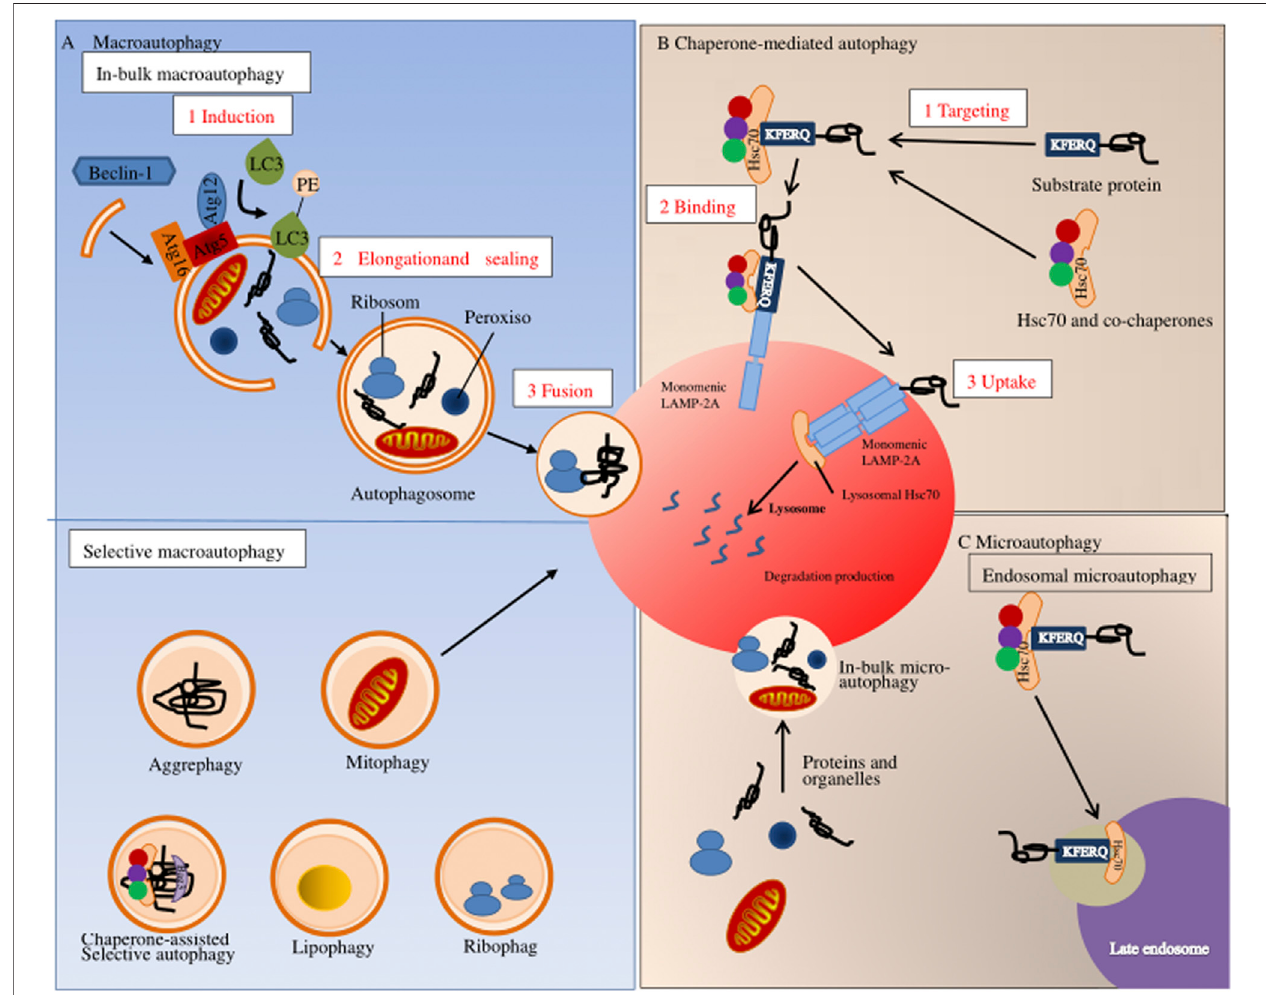
FIGURE 2 | Autophagy pathways in mammals. Autophagy in mammals can be divided into three types: (A) macroscopic autophagy; (B) chaperone-mediated autophagy; (C) microautophagy.